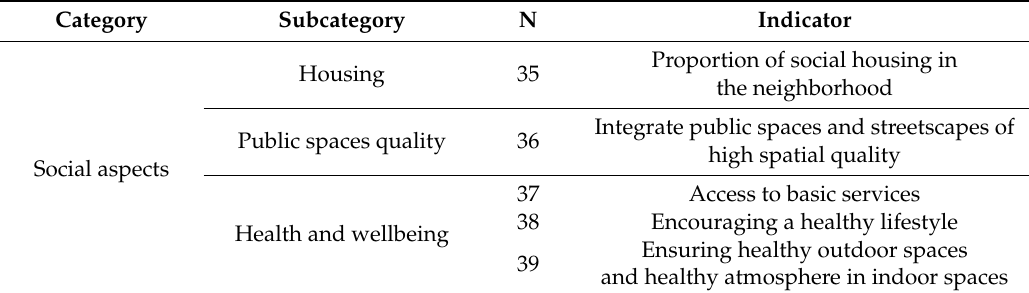
Table 5. Proposed indicators for social